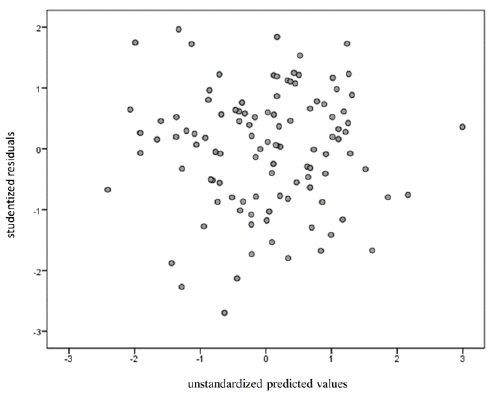
Figure 3. Studentized residuals were plotted against the unstandardized predicted values to ex- amine